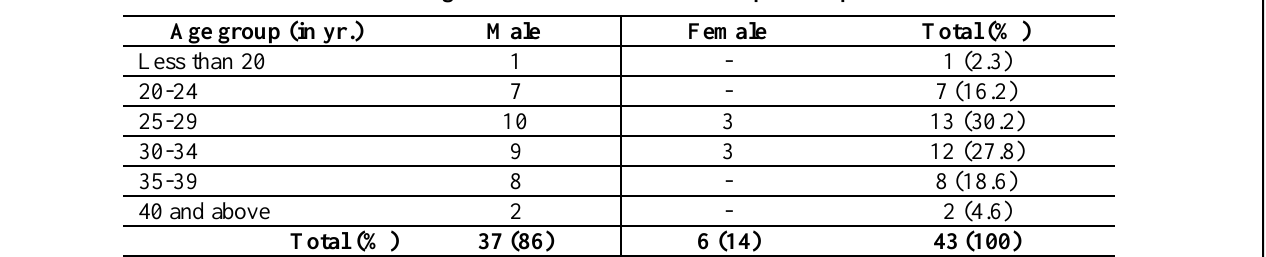
Table II : Age & sex distribution of HIV positive